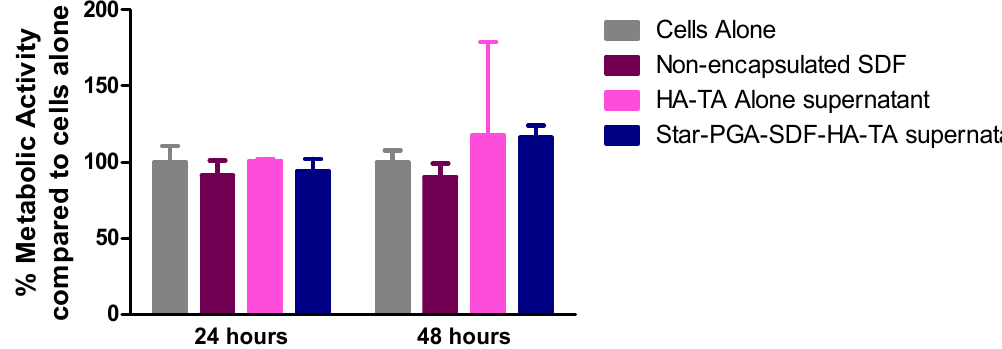
Figure 7. Metabolic activity (MTS assay) of human umbilical vein endothelial cells (HUVECs) exposed to 4.1 ng/mL fresh, non-encapsulated Stromal-Derived Factor 1 α (SDF), supernatant from a HA–TA hydrogel or star-poly(glutamic acid) (PGA)–SDF (50:1)-HA–TA supernatant containing 4.1 ng SDF. ( n =